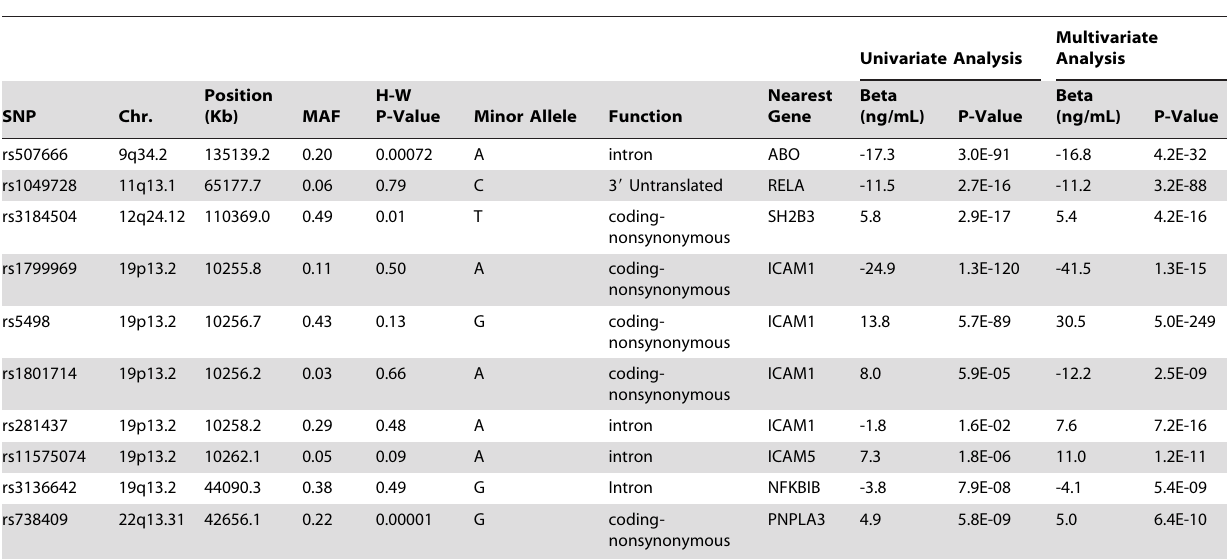
Table 1. SNPs retained by the model selection algorithm.